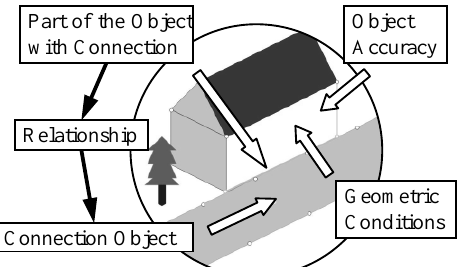
Figure 1. Geodata Join information shown by way of example for a building